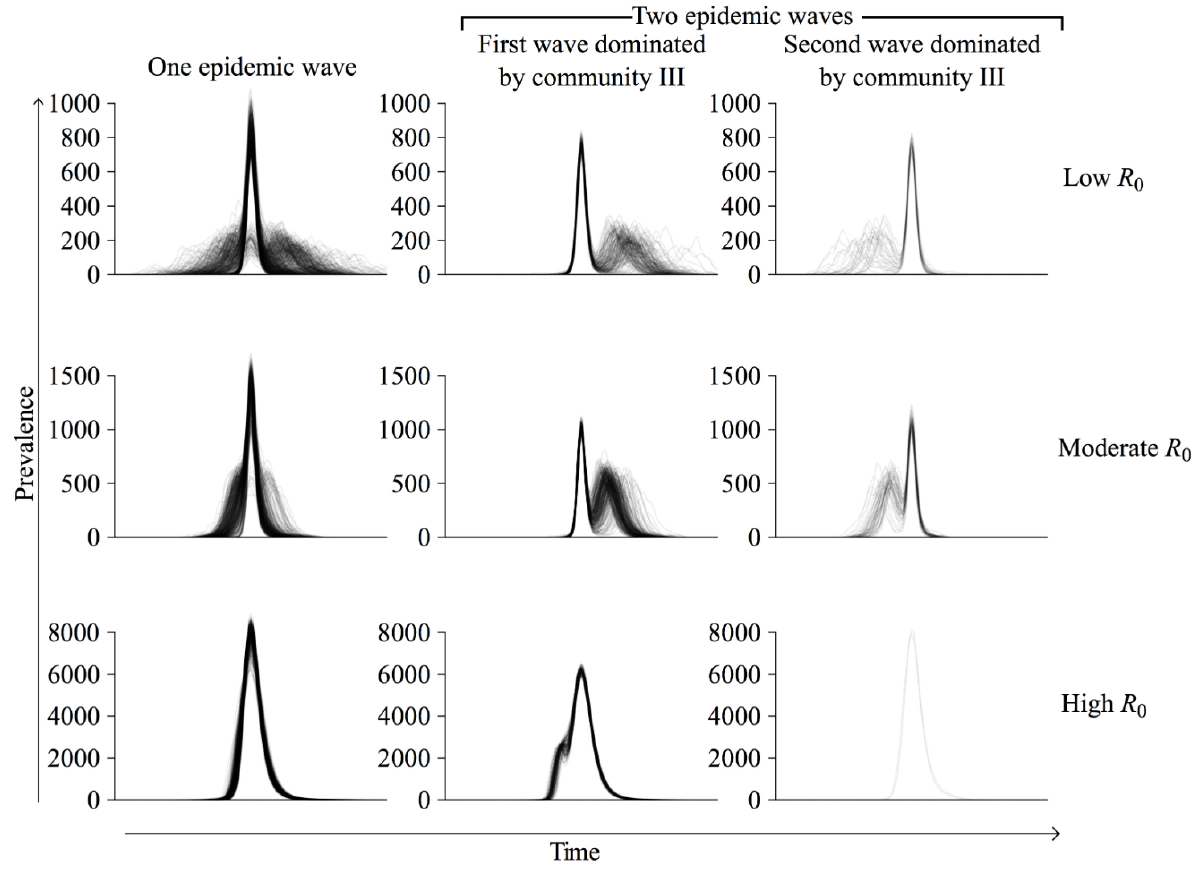
Figure 4. Taxonomy of epidemic curves. For each R 0 , 1000 simulated epidemics were classified as either single-wave (left), multiwave starting with a community III wave followed by a community I and II wave (middle), or multiwave ending in a community III wave (right). At R 0 =2.4, 554 of 1000 (55.40%) had a single wave and 446 of 1000 (44.60%) had 2 waves; of the 446 with 2 waves, community III dominated the first wave in 392 (87.89%). At R 0 =1.9 and R 0 =7.5, only 22.20% (222/1000) and 20.60% (206/1000) of epidemics exhibited 2 waves, respectively. Time series are superimposed so that the peaks of the largest waves align.